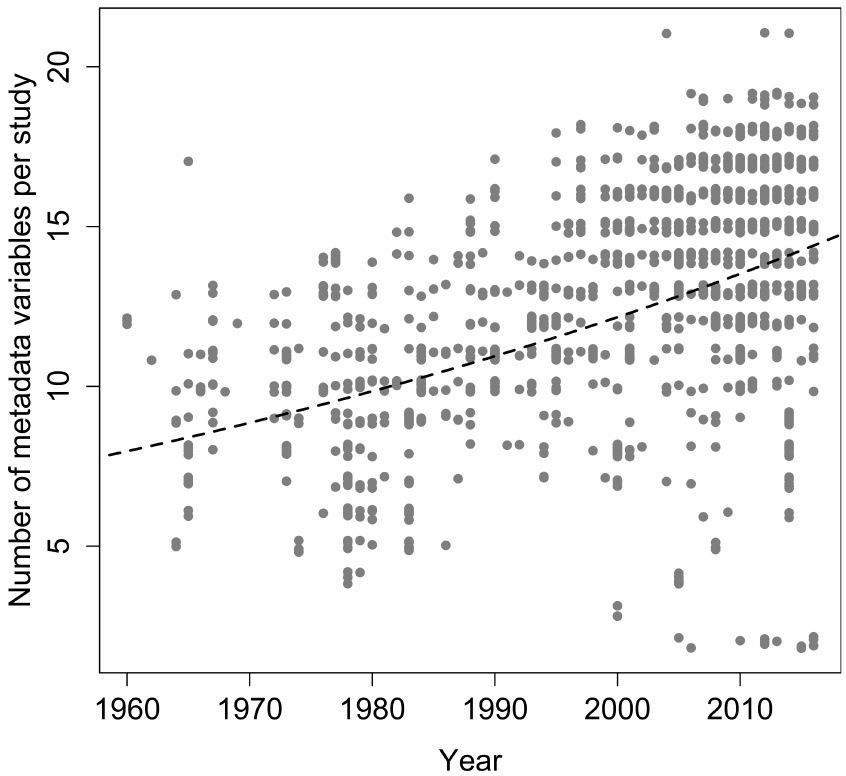
Fig 3. Evolution in the presence of metadata in the studies with descriptions of advertisement calls of Brazilian anurans between 1960 and 2016. Regression function and line fitting the number of metadata variables provided in each study and the year in which was